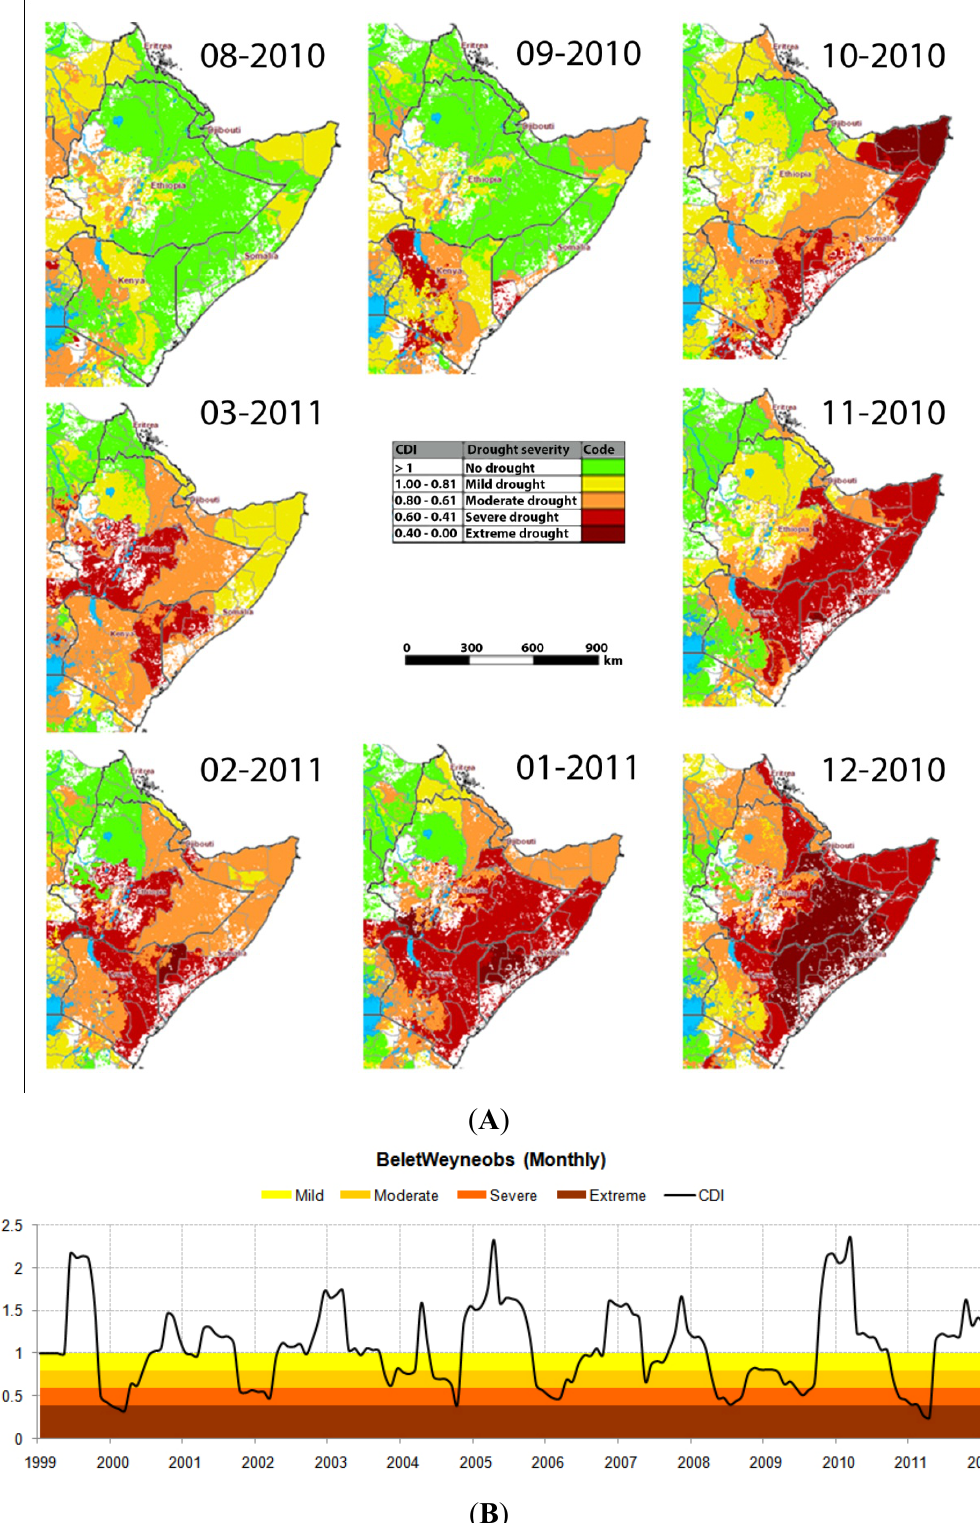
Figure 8. Application of the combined drought index (CDI) for the Greater Horn of Africa [97]. ( A ) Maps depicting the situation in 2010–2011. ( B ) Time profile of CDI from 1999 to 2012 for Belet Weyne